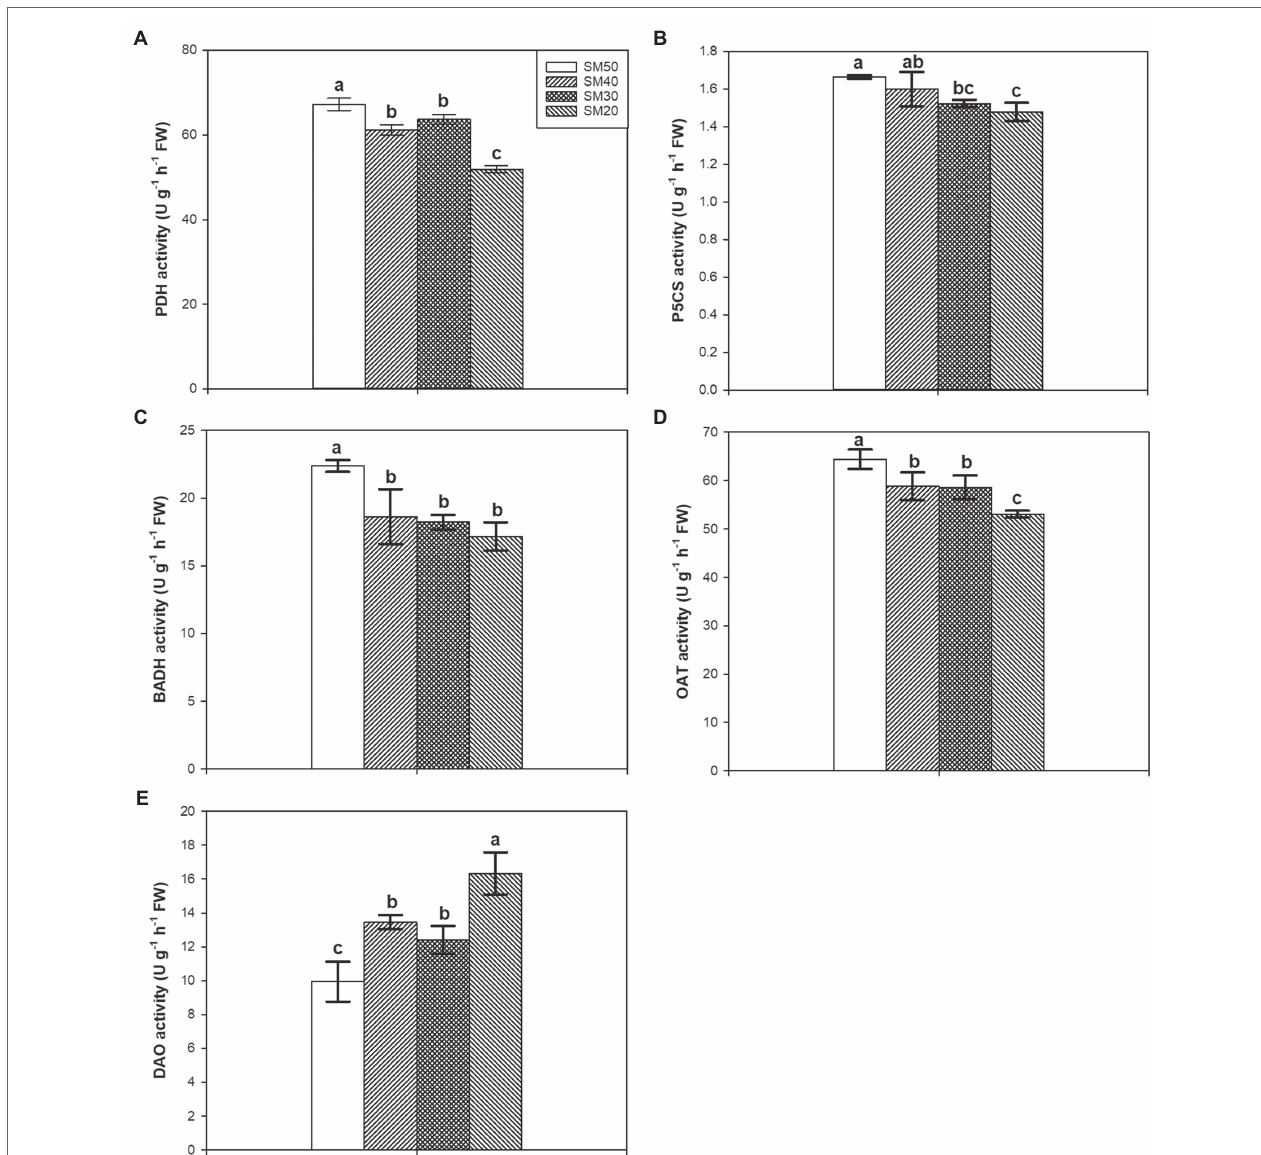
FIGURE 5 | Effects of different soil moisture contents on activities of PDH (A) , P5CS (B) , BADH (C) , OAT (D) , and DAO (E) in fragrant rice. Each column represents the mean of three data ± standard error ( n = 3). Bars sharing a common letter do not differ significantly at ( p <